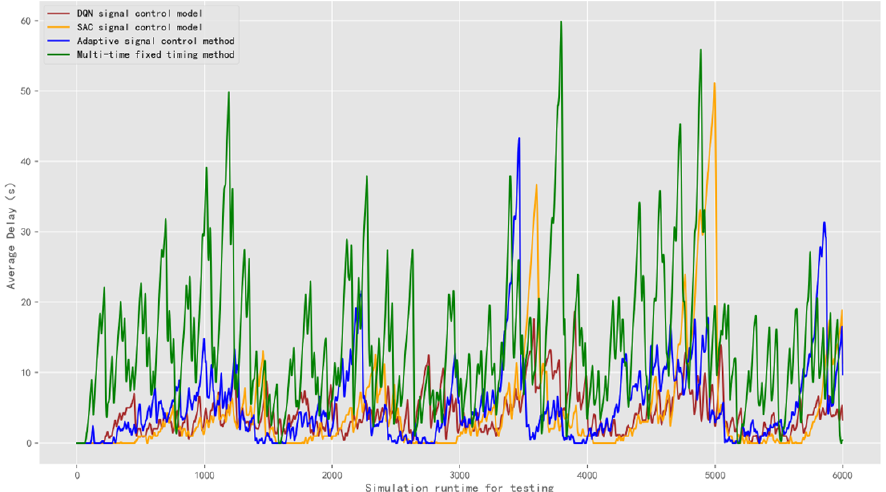
Figure 14. Comparison of the average delay of signal control methods under test traffic scenario 1.